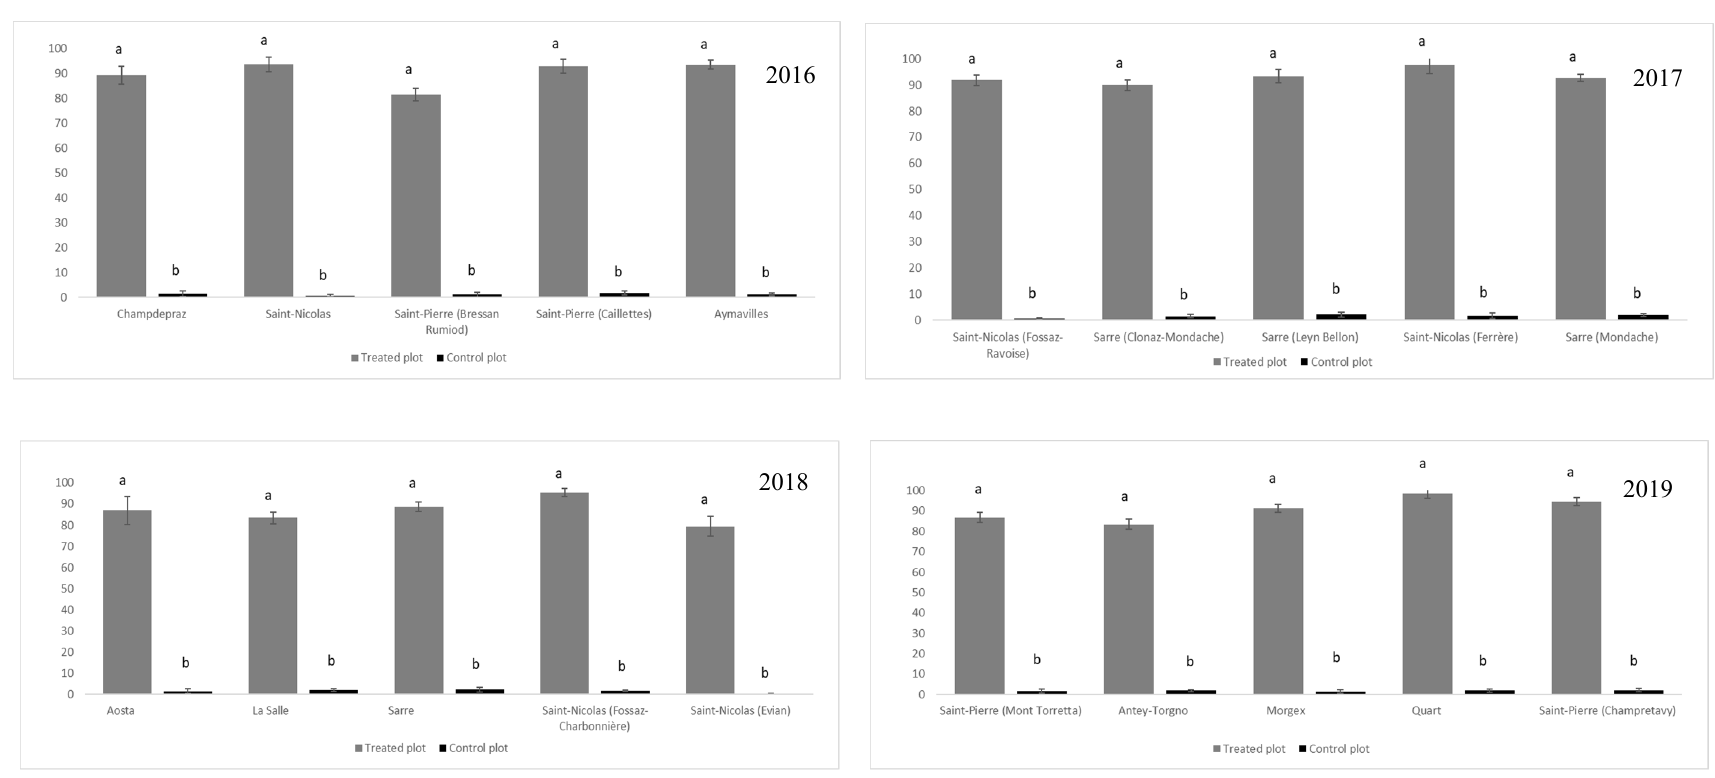
Figure 3. Percentage mortality of PPM larvae (± SEM) recorded inside the nests collected in treated and control plots after applications of Bacillus thuringiensis var. kurstaki in 2016–2019. Bars with different letters are significantly different, according to the paired t -test ( p < 0.05).